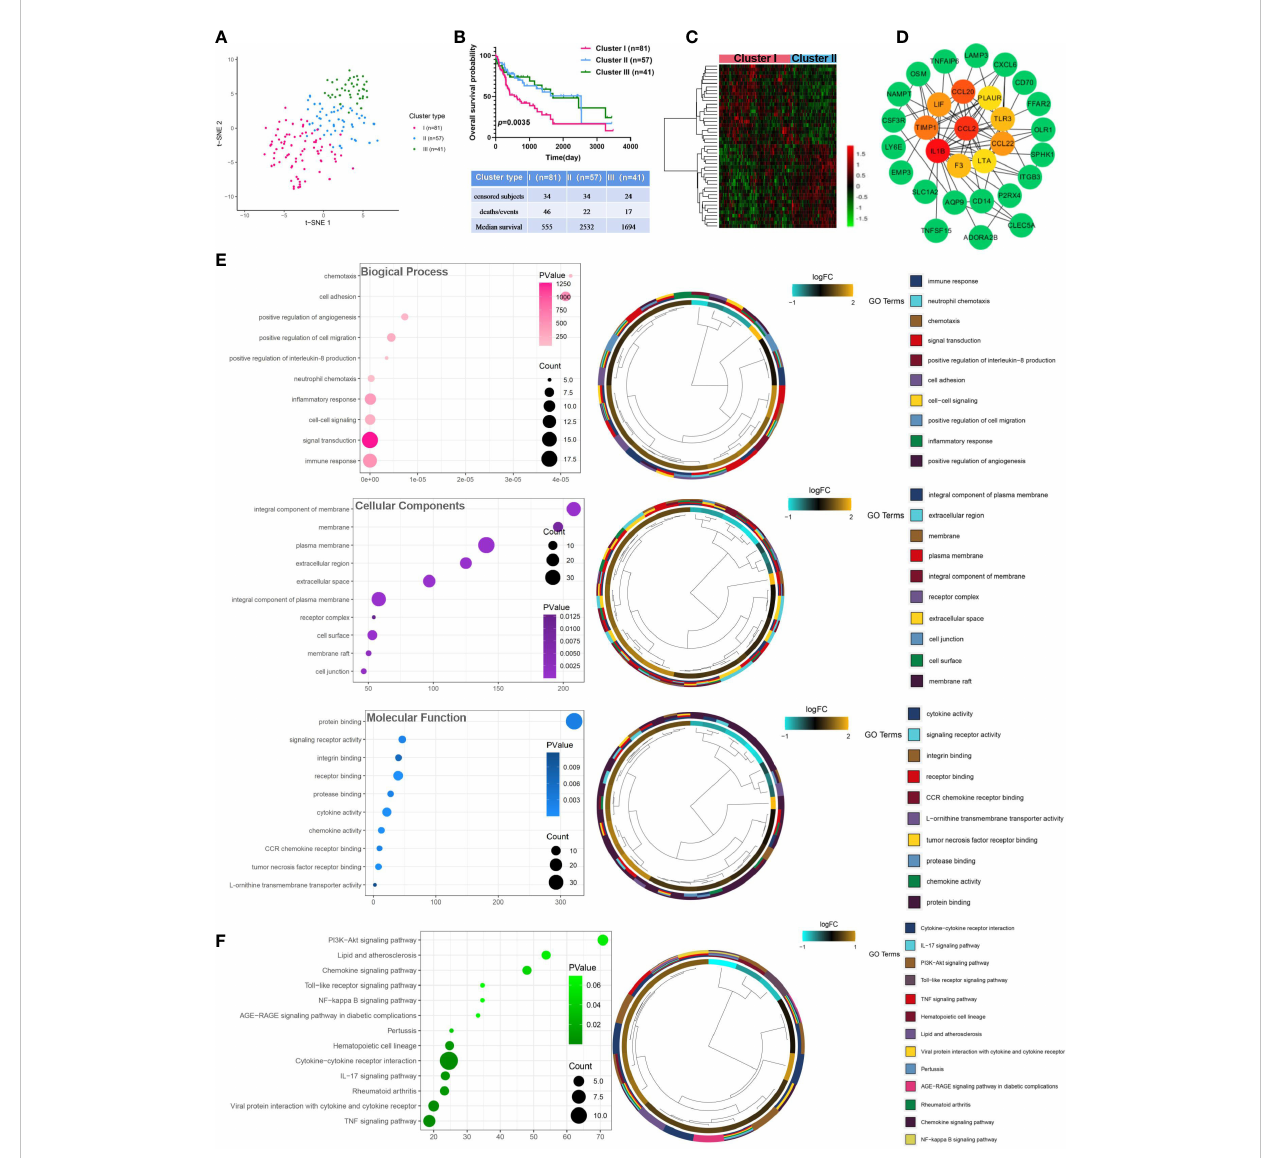
FIGURE 2 Identi fi cation and analysis of in fl ammation-related differentially expressed genes in virus-related HCC. (A) Dot plot for three distinct clusters identi fi ed by t-SNE algorithm based on 200 in fl ammation hallmark genes. (B) Kaplan-Meier plot of overall survival for patients in three clusters. (C) Heatmap showing expression pro fi les for in fl ammation-related DEGs with comparison between cluster I (in fl ammation high ) and cluster II (in fl ammation low ) groups. (D) The Protein-protein interaction (PPI) network between 47 differentially expressed in fl ammation-related genes (IRGs). (E) Gene Ontology (GO) and (F) Kyoto Encyclopedia of Genes and Genomes (KEGG) enrichment analysis for IRGs. Adjusted p < 0.01 and p < 0.05 were considered signi fi